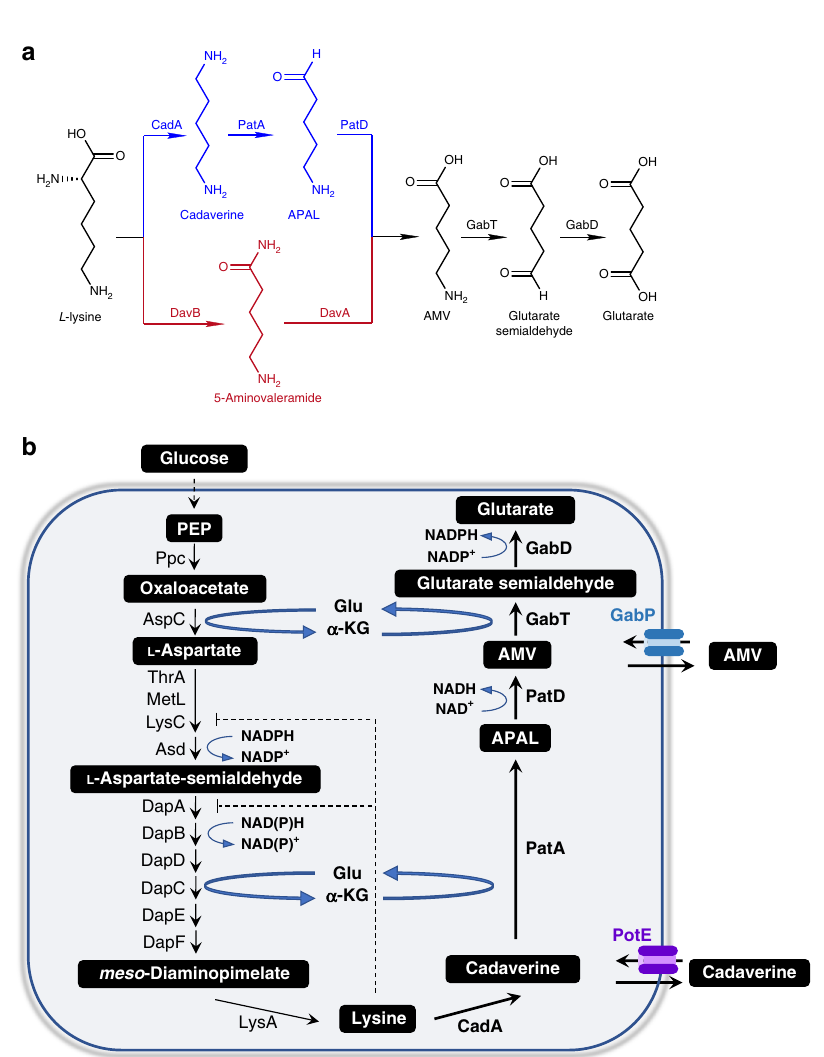
Fig. 1 Glutarate biosynthesis via lysine catabolism. a The Cadaverine pathway (blue color) and the AMV pathway (red color) from lysine to glutarate. b E. coli native pathway for glutarate biosynthesis. Thick arrows indicate gene overexpression. Enzymes: CadA, lysine decarboxylase; DavA, delta- aminovaleramidase; DavB, lysine 2-monooxygenase; GabD, succinate-semialdehyde dehydrogenase; GabT, 4-aminobutyrate-2-oxoglutarate transaminase; PatA, putrescine aminotransferase; PatD, aminobutyraldehyde dehydrogenase. Metabolites: Glu, glutamate; α -KG, α -ketoglutarate; PEP, phosphoenolpyruvate; APAL, 5-aminopentanal; AMV,